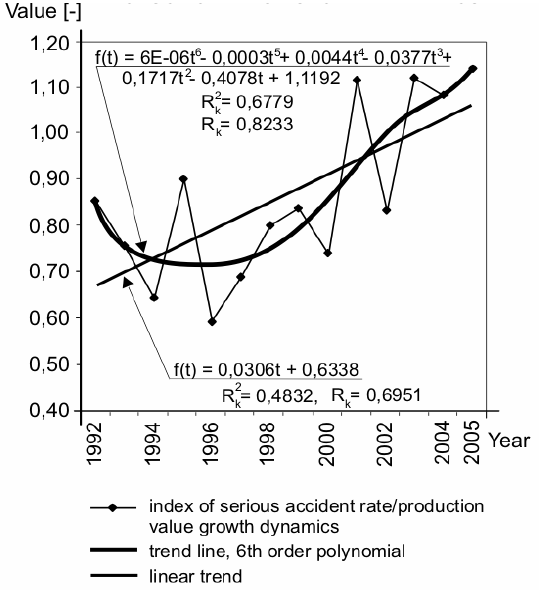
Fig 10. Index of serious accidents rate dynamics relative